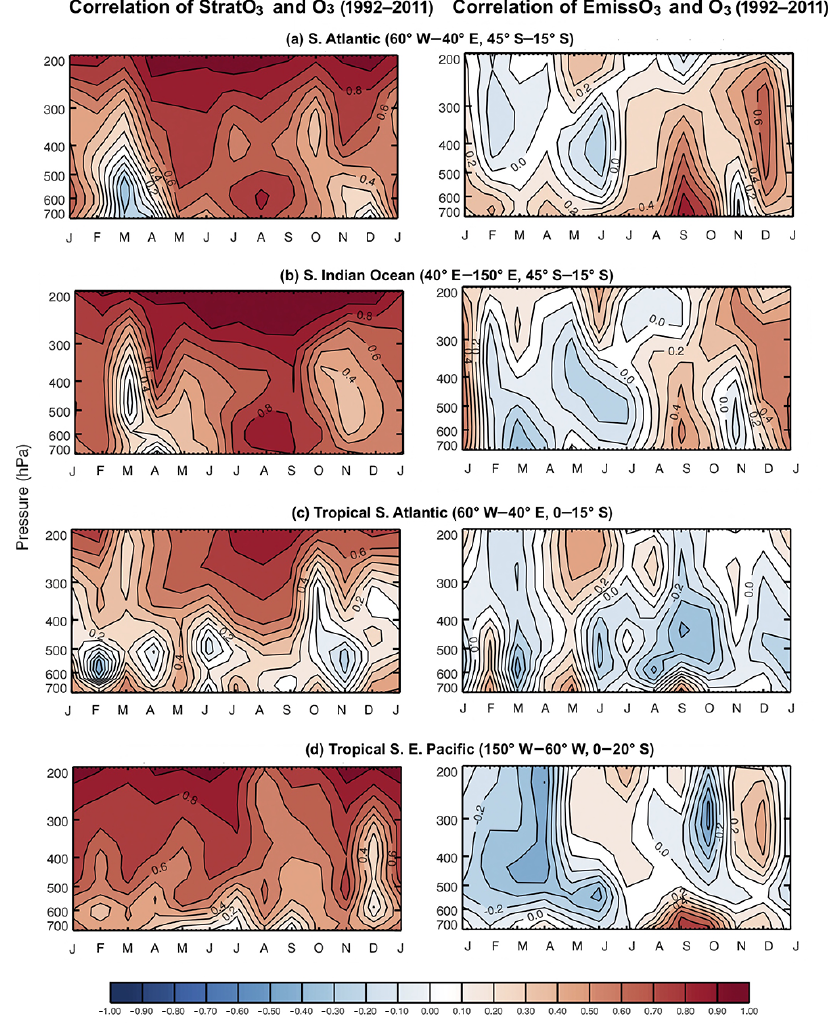
Figure 6. Monthly profile maps of correlation coefficients between ozone and (left) StratO 3 and (right) EmissO 3 from 1992 to 2011 over the (a) South Atlantic (60 ◦ W–40 ◦ E, 15–45 ◦ S); (b) South Indian Ocean (40–150 ◦ E, 15–45 ◦ S); (c) tropical South Atlantic region (60 ◦ W–40 ◦ E, 0–15 ◦ S); and (d) tropical southeastern Pacific (150–60 ◦ W, 0–20 ◦ S). The y axis is pressure in pascal units